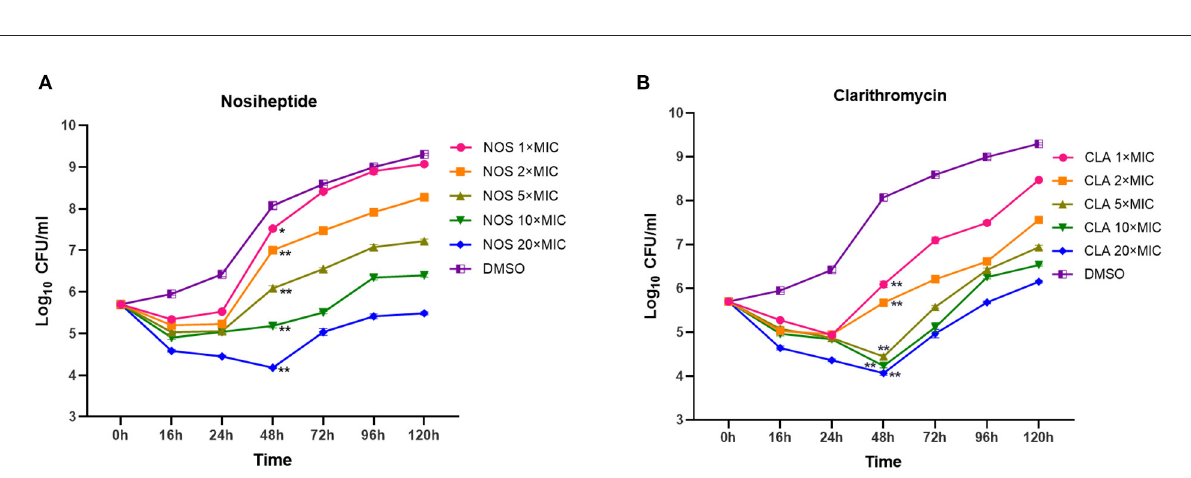
FIGURE3 Time-kill kinetics of (A) NOS and (B) CLA against M. abscessus ATCC 19977. Antibiotic concentrations are presented as different symbols. Dimethyl sulfoxide (DMSO) was used as a negative control, and CLA was used as a positive control. * P < 0.05; ** P <